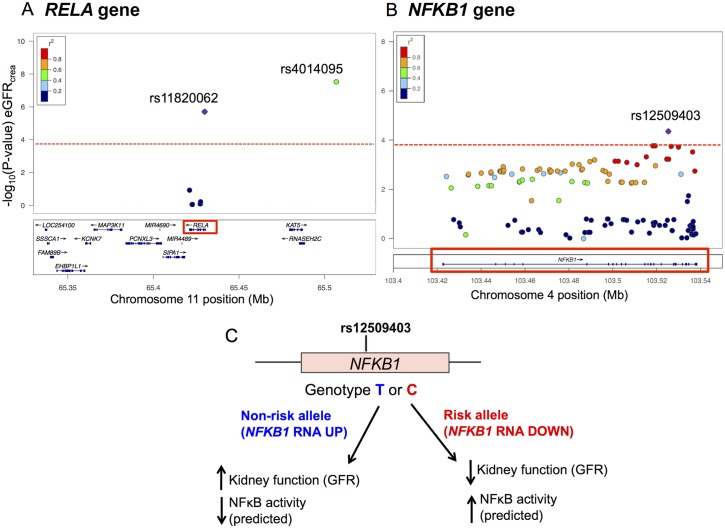
Genetic variation in NFκB genes associates with kidney function and chronic kidney disease.A. The regional association plot shows each SNP tested in the RELA gene arranged by its position on chromosome 11 (x-axis) with the–log10(p-value) for association with eGFR on the y-axis. The purple diamond represents the lead SNP within the RELA gene rs11820062. The colors of flanking SNPs in RELA represent their linkage disequilibrium (R2) with the lead SNP. The green dot represents rs4014195, an intergenic SNP that was previously associated with kidney function at genome-wide significance [40]. rs4014195 is moderately linked to rs11820062 in RELA (R2 = 0.44). Dotted line indicates Bonferroni significance level. B. The regional association plot shows each SNP tested in the NFKB1 gene arranged by its position on chromosome 4 (x-axis) and the log10(p-value) for their association with eGFR on the y-axis. The purple diamond represents the lead SNP rs12509403. The color of dots representing flanking SNPs in the NFKB1 gene indicates their linkage disequilibrium (R2) with the lead SNP as indicated in the heat map color key. Red dotted line indicates Bonferroni significance level. C. The schematic illustrates how rs12509403 genotype influences both NFKB1 gene expression and kidney function. Rs12509403 correlates with NFKB1 gene expression such that the T allele is associated with higher NFKB1 mRNA expression and higher eGFR, while the C allele is associated with reduced mRNA expression and lower eGFR.